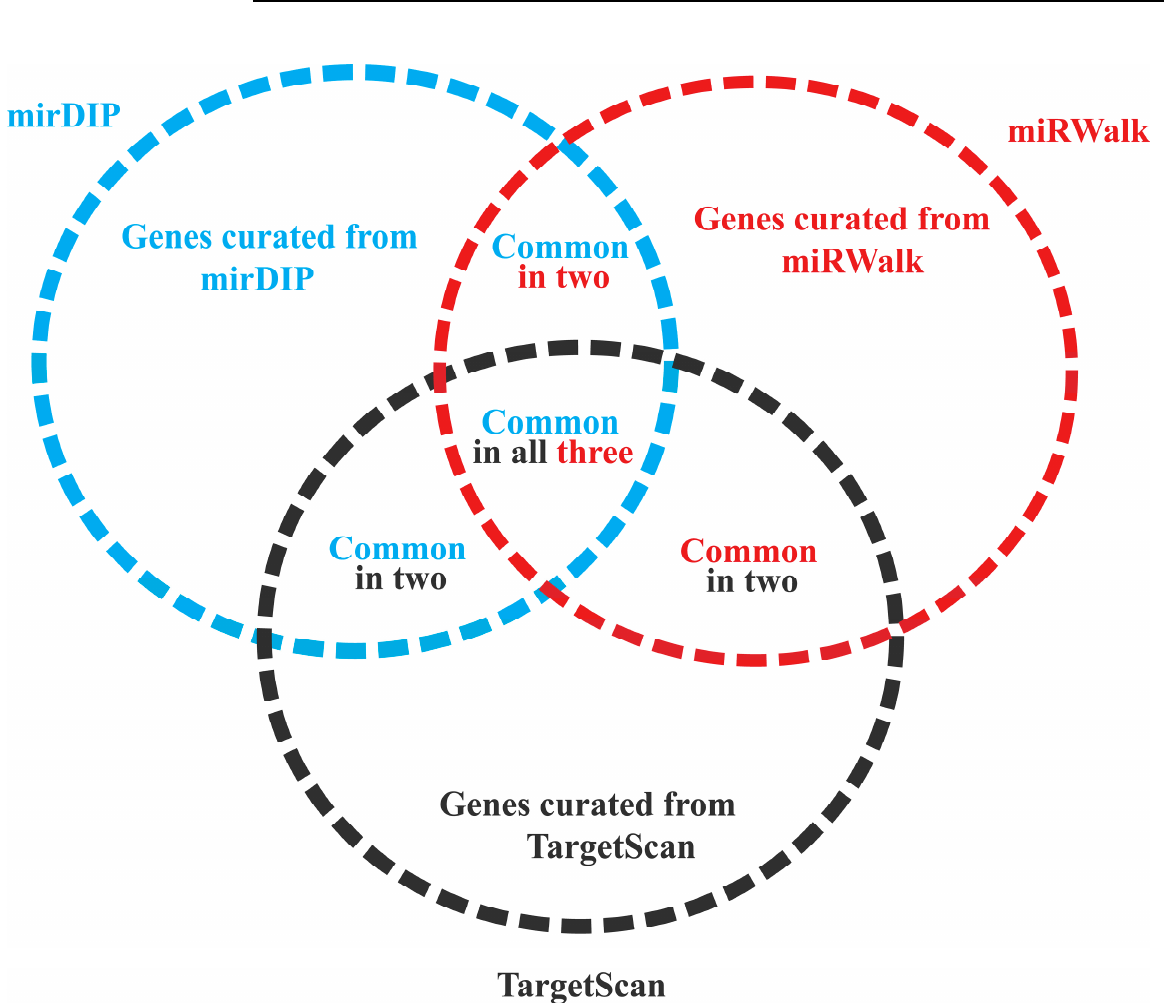
Figure 1. The overlapping genes taken from all three databases were found using a Venn analysis. Top 10 DEMs were extracted from These 741 downregulated genes and 1115